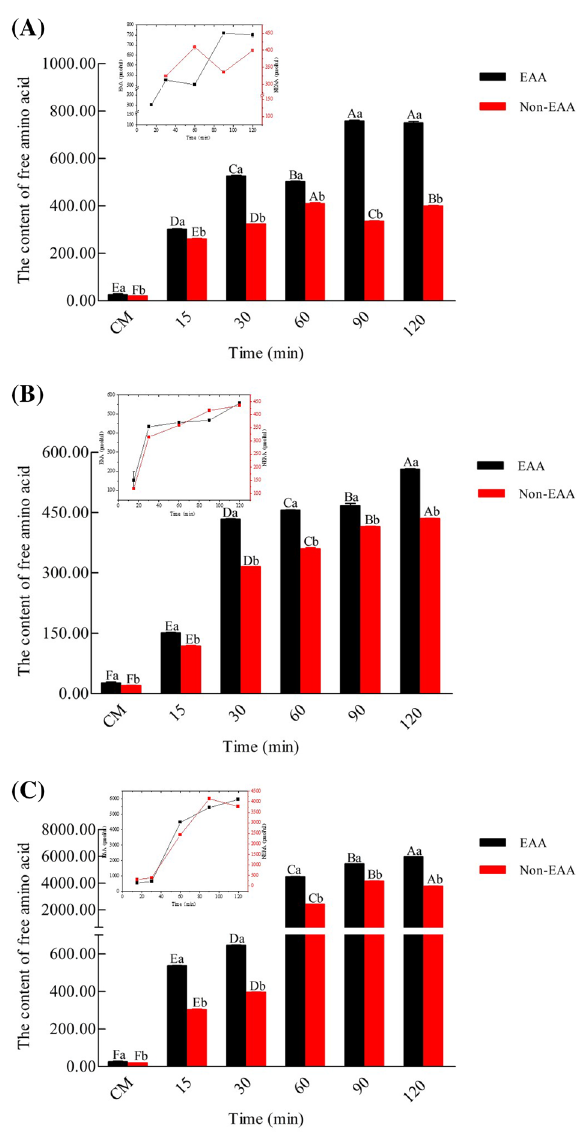
Figure 6. The content of amino acids of CM, AT ( A ), PT ( B ) and FT ( C ). Alcalase-treated cow milk (AT), Protamex-treated cow milk (PT), Flavourzyme-treated cow milk (FT). Essential amino acids (EAAs); Non- essential amino acids